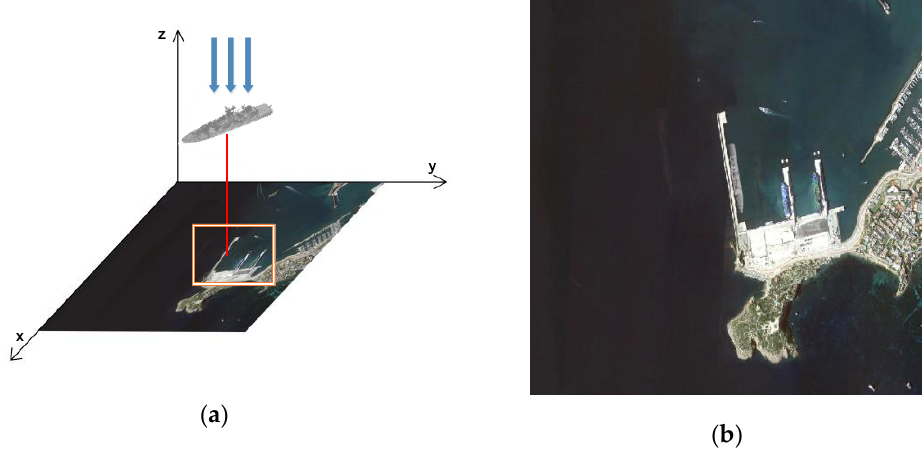
Figure 4. ( a ) Schematic of simulation image generation. ( b ) The image generated from Figure